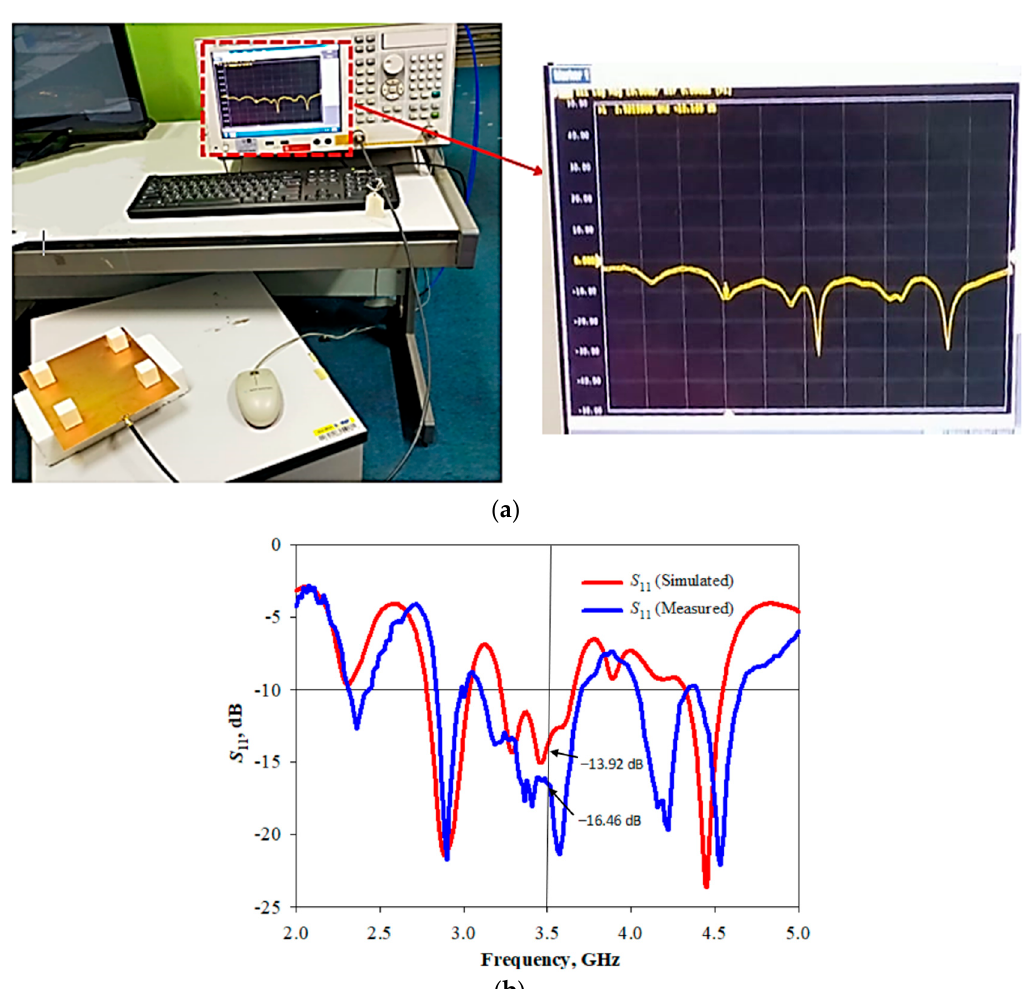
Figure 5. Re fl ection coe ffi cient of the proposed antenna. ( a ) Measurement setup; ( b ) simulated and Figure 5. Reflection coefficient of the proposed antenna. ( a ) Measurement setup; ( b ) simulated and measured results of the re fl ection coe ffi cient. measured results of the reflection